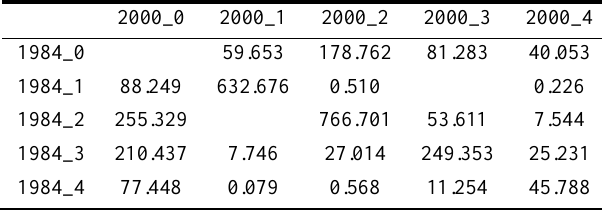
Table 1 Classified lake transfer matrix from 1984 to 2000 (Unit: